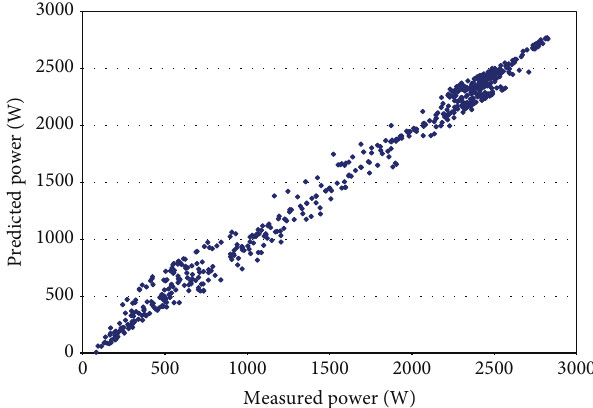
Figure 8: Output power prediction for Model #2, which selects sunny and cloudy data separately.